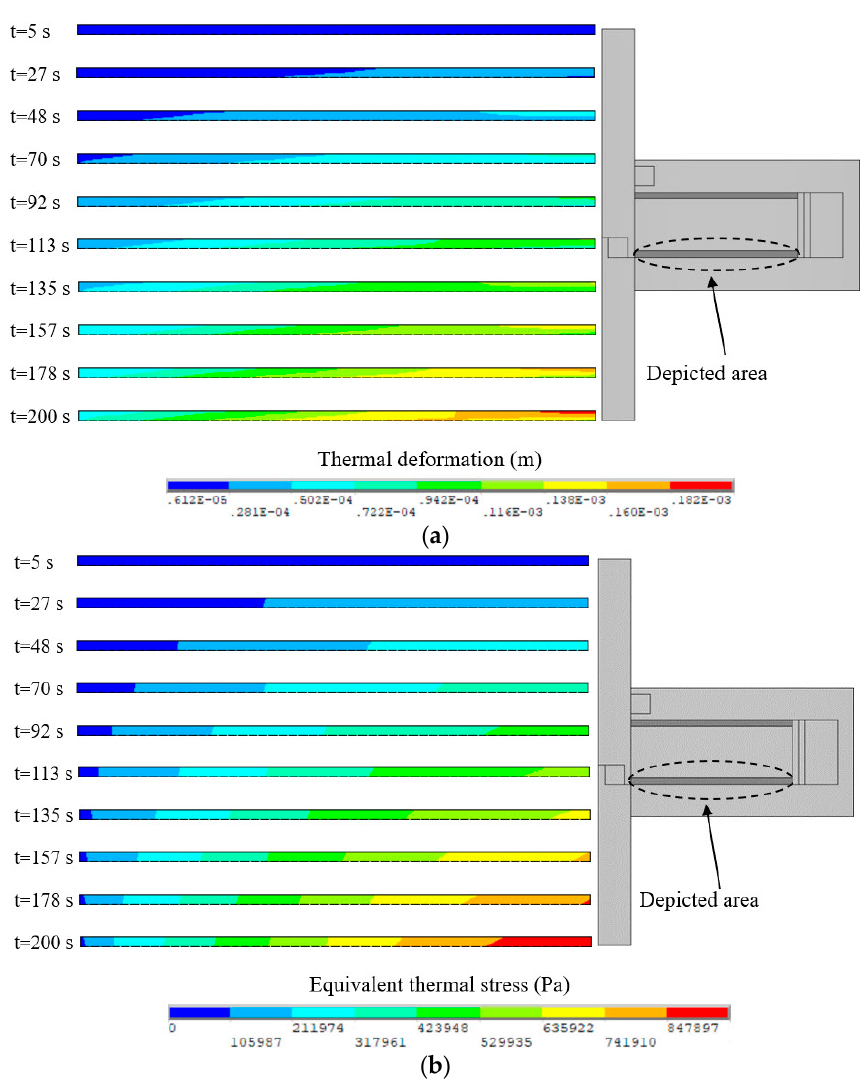
Figure 8. Results of the disc ‐ type MRC: ( a ) Thermal deformation of MRFs; ( b ) Equivalent thermal stress of MRFs.